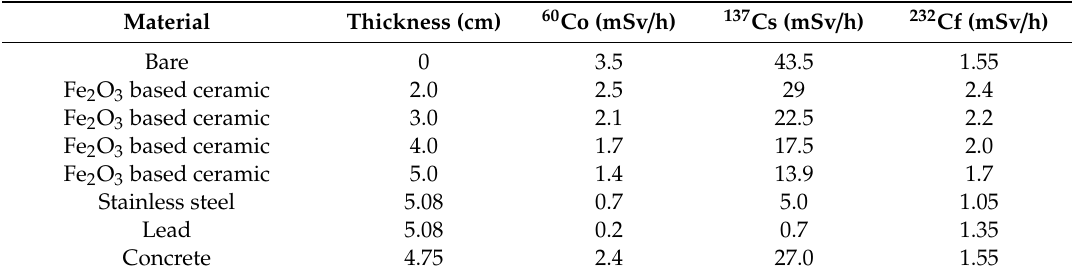
Table 4. Dose rate measurement of the Iron (III) oxide-based ceramic for gamma ray and neutron from the indicated radiation sources.